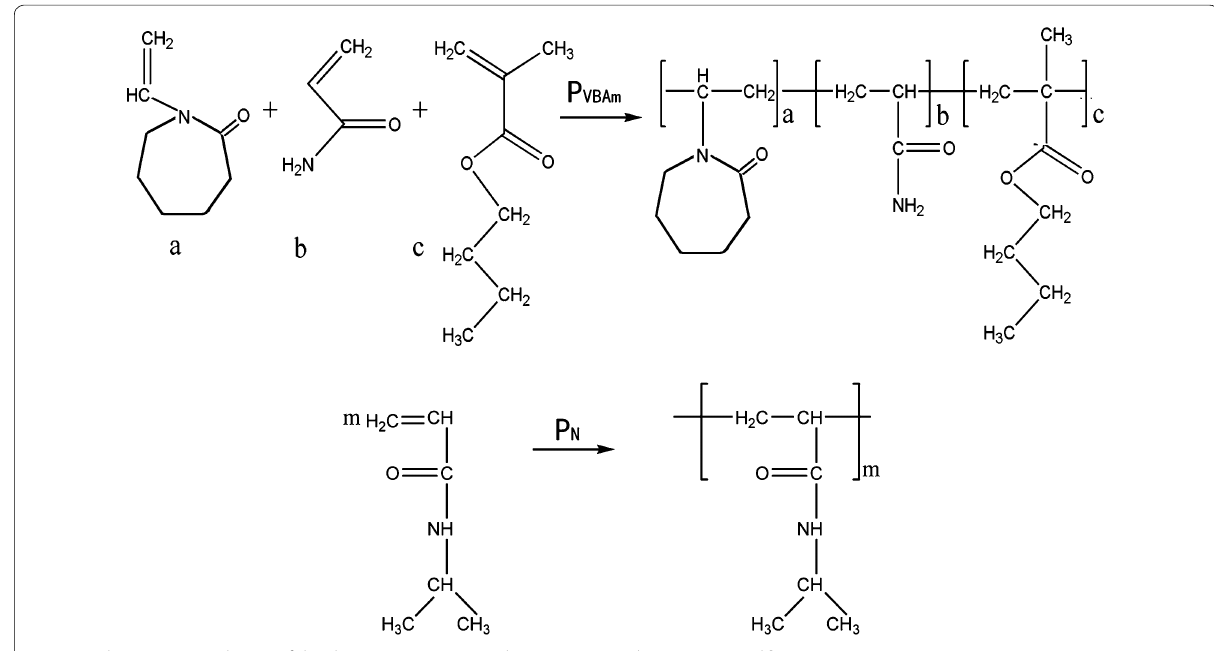
Fig. 1 Polymerization scheme of the thermo-responsive polymers P VBAm and P N . a P VBAm and b P